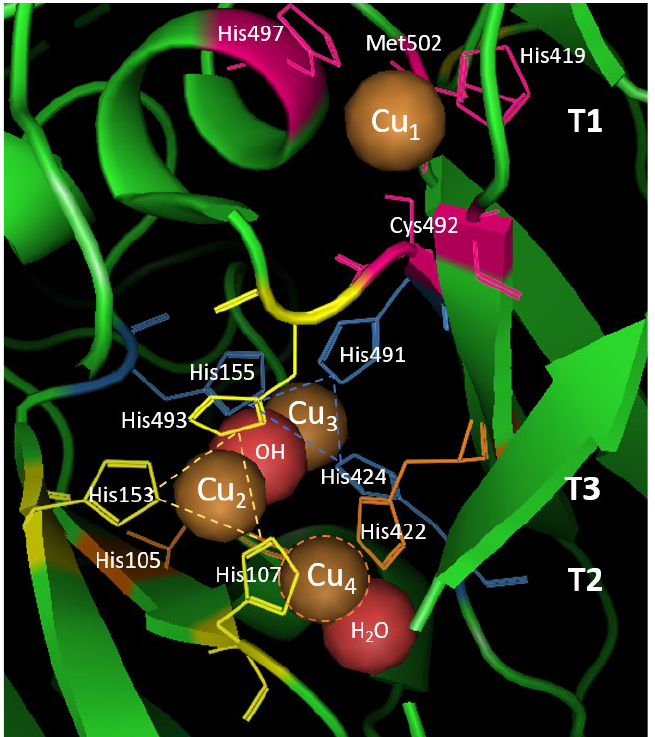
Figure 3. Detail of CotA laccase active site from Bacillus subtilis . In pink, the four ammino acids that coordinate with the Type1 copper; in yellow and blue, the three histidines residues that coordinate with Type3 copper atoms; in orange, the two histidines that bind with Type2 copper atoms. PDB code: 1gsk.